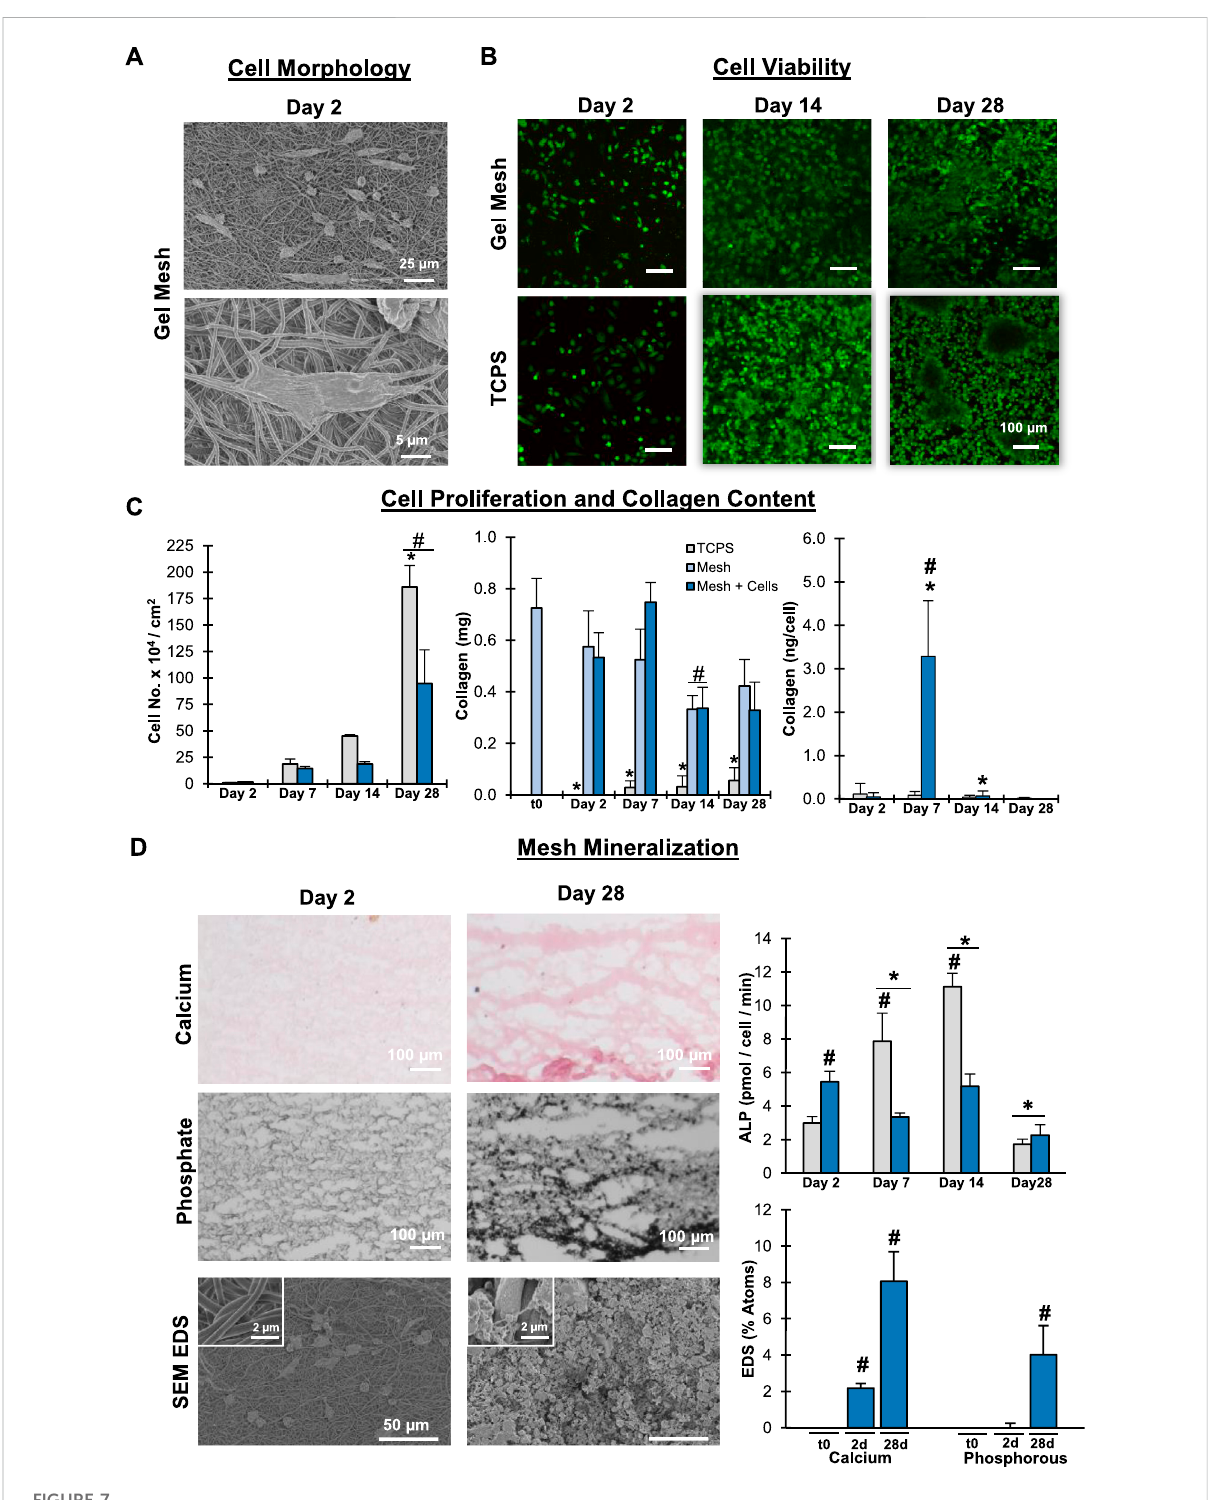
FIGURE 7 MeshBiocompatibility: Human Osteoblast-likeCells. Mesheswerebiocompatibleand supported Saos-2 cell attachment, growth,and matrix mineralization. (A) Cell/matrix interactions (day 2, SEM, 500x, 3,000x). (B) Cell Viability. (C) Cell proliferation and matrix stability ( n = 5). (D) Matrix mineralization qualitatively by Von Kossa and Alizarin Red histological stains and quantitatively by alkaline phosphate activity ( n = 5) and SEM EDS (SEM, 500x, n = 5 regions per mesh). #= p < 0.05 between groups, * = p < 0.05 over